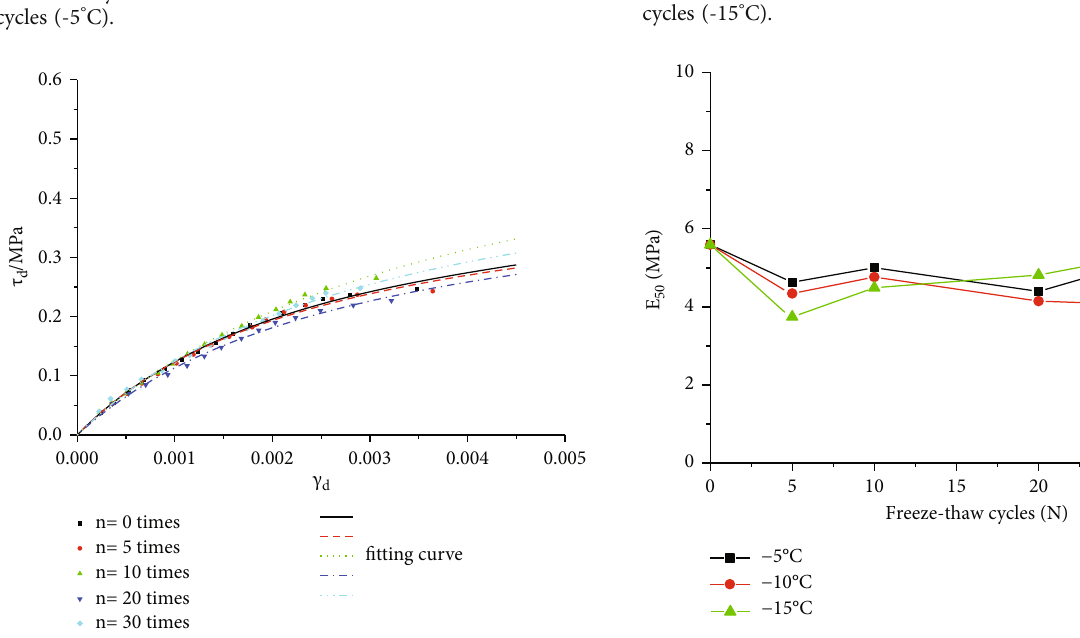
Figure 8: Dynamic stress-strain curves under di ff erent freeze-thaw cycles (-10 ° C).